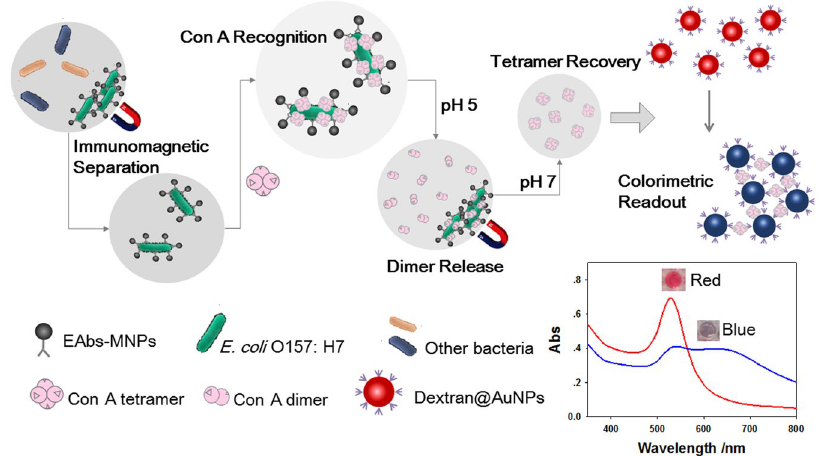
Figure 1. Illustration of the procedures and mechanism of the colorimetric